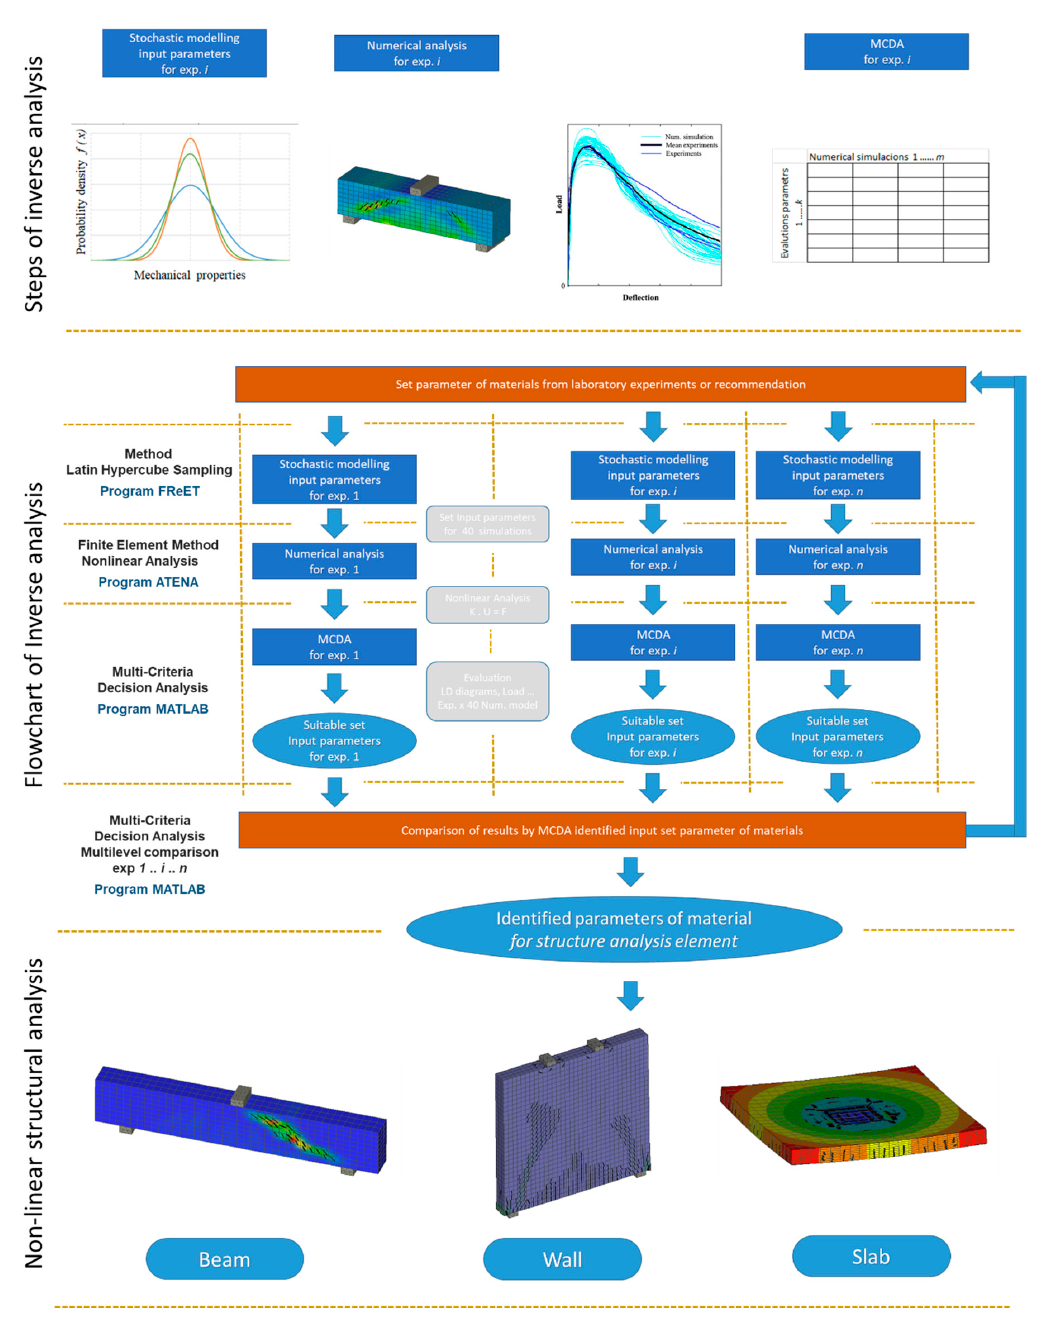
Figure 1. Flowchart of inverse analysis and structural analysis of structural elements.